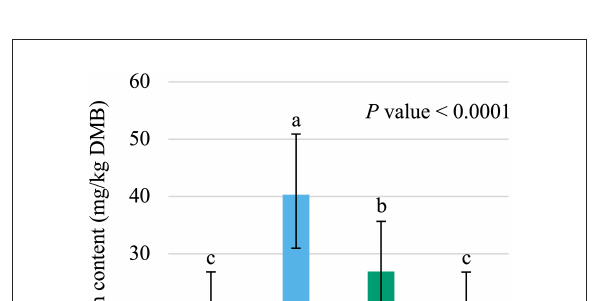
FIGURE1 Main effect of vitamin premix inclusion on dry matter basis (DMB) thiamin content (average with 95% confidence interval) of canned cat foods stored in a commercial warehouse for 6 months. a,b Means without a common superscript are different ( P < 0.05).